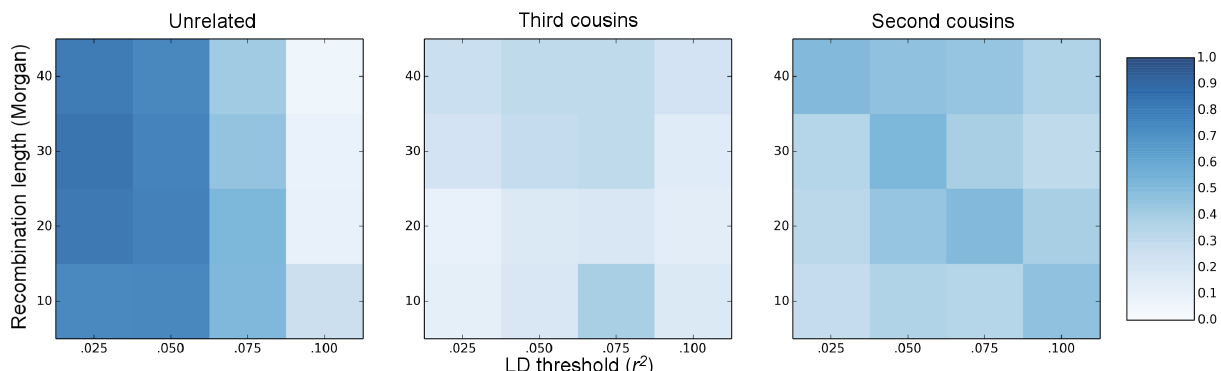
Fig 2. Effects of LD-pruning on pairwise prediction accuracy. The three panelsshow different true pairwiserelationships: unrelated,third cousins, and second cousins. Each square in a panel corresponds to the relationship predictionaccuracyfor a particulargenome lengthand LD-prunethreshold. The color indicatesthe accuracyrate between0 and 1.